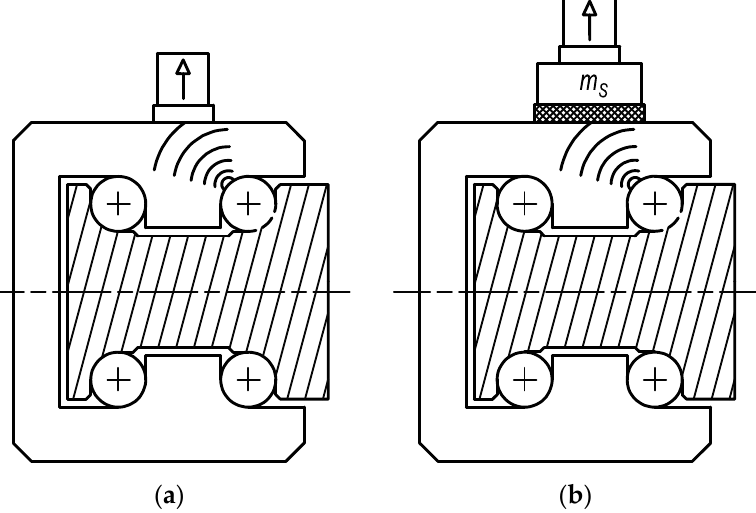
Figure 4. The scheme of sensor connection: ( a ) with magnet; and ( b ) with rubber spring and additional weight.